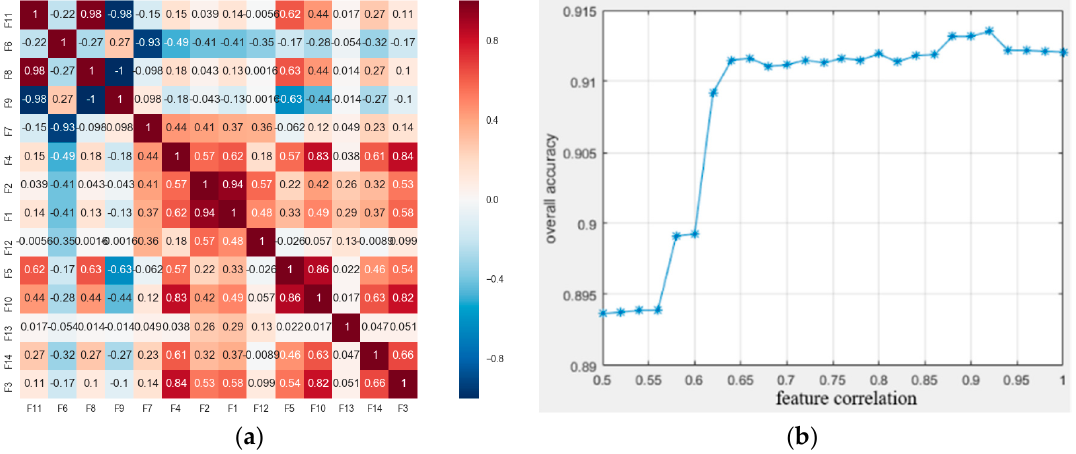
Figure 5. Relationship between feature correlation selection and classification accuracy. ( a ) Feature correlation heat map; ( b ) relationship between feature correlation and accuracy.